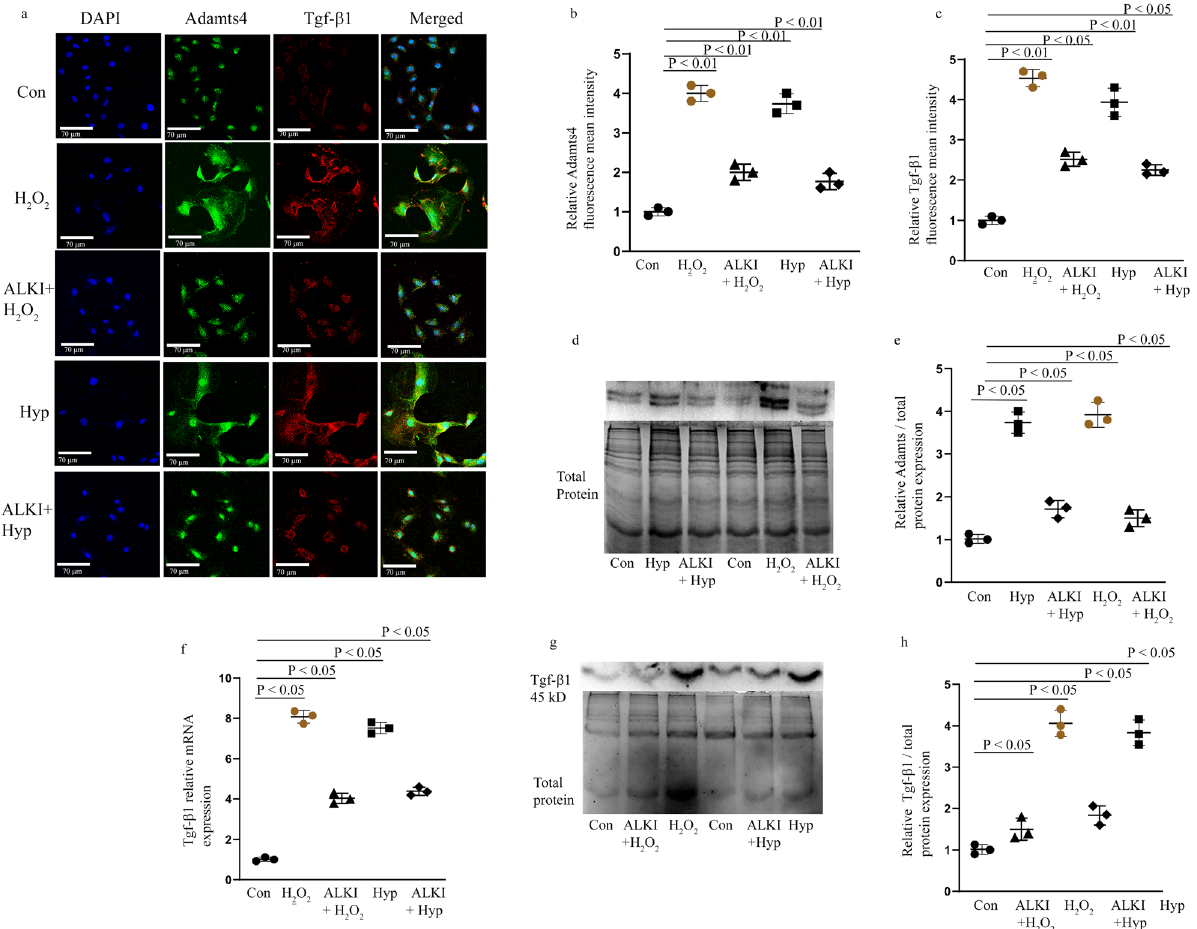
Figure 4. Adamts4 and Tgf-β1 expression is inhibited following pre-treatment with ALKI. Staining with anti-Adamts4 (shown in green) showed a 4- and 3.7-fold increase following H 2 O 2 and hypoxia treatments in the fluorescence intensities of Adamts4 but was found to reduce to 2 and 1.6 folds in the treatment groups— ALKI + H 2 O 2 and ALKI + Hypoxia respectively ( a and b ). IF with anti-Tgf-β1 antibody (shown in red) showed elevated expression of 4.5 and fourfold following H 2 O 2 and hypoxia treatments and this reduced to 2.5 and 2.3 folds for ALKI + H 2 O 2 and ALKI + Hypoxia groups ( a and c ). DAPI (in blue) was used as nuclear stain. Adamts4 WB shows of increased expression of 3.7 and 4 folds for the Hyp, H 2 O 2 treated groups which reduce to 1.7, and 1.5 in ALKI + Hyp and ALKI + H 2 O 2 treated groups ( d and e ). Tgf-β1 inhibition following ALKI pre-treatment was also assessed by qPCR ( f ) which showed a reduction from 8 and 7.4 folds for H 2 O 2 and hypoxia treatment groups to 4 and 4.4 folds for ALKI + H 2 O 2 and ALKI + Hyp treatment groups. Tgf-β1 protein expression measured by WB ( g and h ) showed a 4- and 3.8-fold increased change for H 2 O 2 and Hypoxia subjected H9c2 cells to 1.5 and 1.8 folds for ALKI + H 2 O 2 and ALKI + Hyp treatment respectively. β-actin was used to normalize gene expression for qPCR assay and total protein was used as loading control for WB. n = 3, data analyzed and expressed as mean ± SD. Differences were considered statistically significant for p <